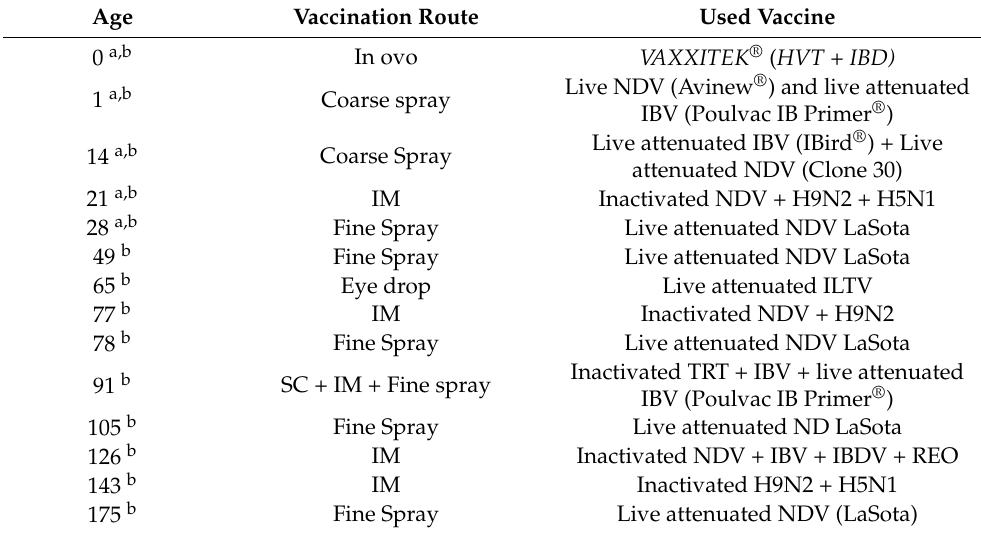
Table 2. Vaccination regime used to vaccinate the Jordanian poultry